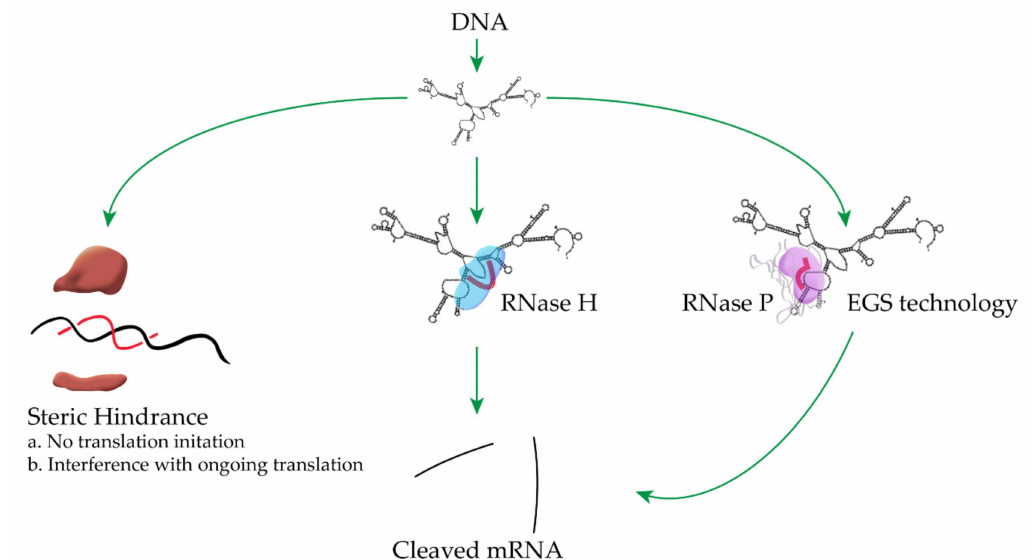
Figure 1. Representative mechanisms of inhibition of gene expression by antisense oligonucleotides. Left—the antisense compound binds the mRNA at the translation initiation region, preventing initiation of translation or at any location of the mRNA, in which case it will interfere with the progress of the ribosome. The figure shows only the binding at the translation initiation region. Center—an antisense oligodeoxynucleotide or analog compatible with activation of RNase H upon binding to RNA binds a single-stranded region of the target mRNA, which becomes a substrate for cleavage by RNase H. Right—External Guide Sequence (EGS) technology, an antisense oligodeoxynucleotide or analog compatible with activation of RNase P binds a single-stranded region of the target mRNA and forms the structure required to become a substrate of RNase P. Figures that include processes shown in this one can be found in recent reviews